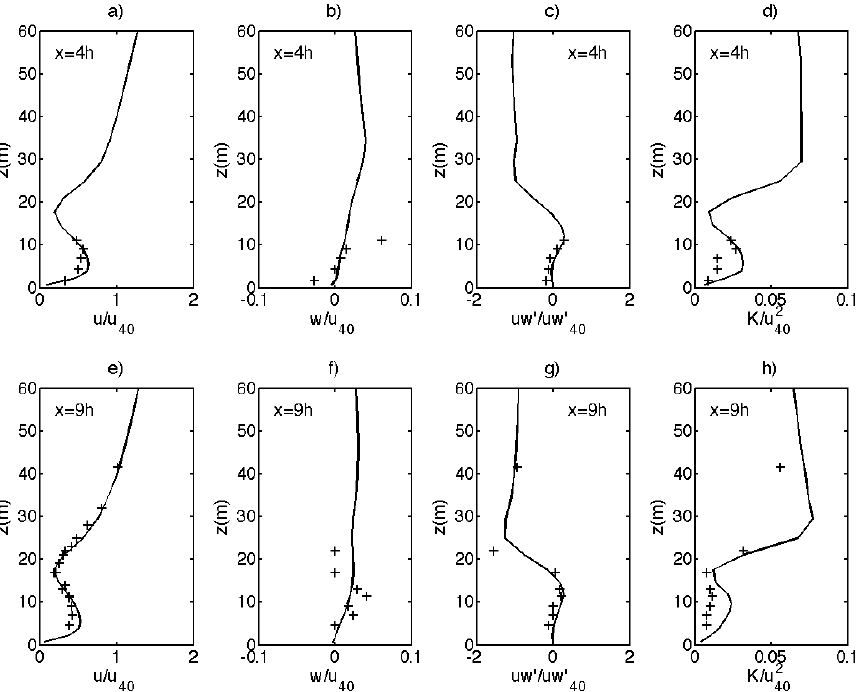
Figure A3. Simulated wind statistics over canopy Can2 with PGF4 (lines), against experimental data (+’s) at x = 4 h : ( a ) u -velocity profile; ( b ) w -velocity profile; ( c ) momentum flux; ( d ) turbulent kinetic energy; and at x = 9 h : ( e ) u -velocity profile; ( f ) w -velocity profile; ( g ) momentum flux; ( h ) turbulent kinetic energy. Atmosphere 2020 , 11 , x FOR PEER REVIEW